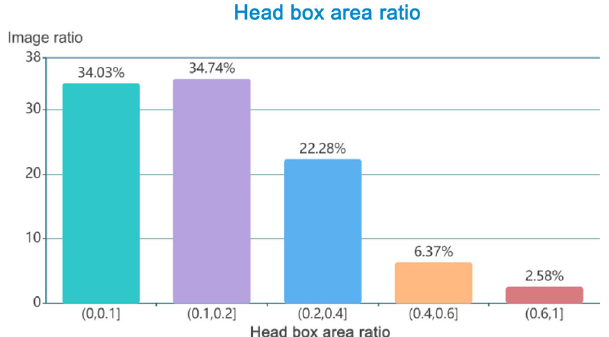
Fig. 9 Fraction of the image covered by the dog’s head bounding box.